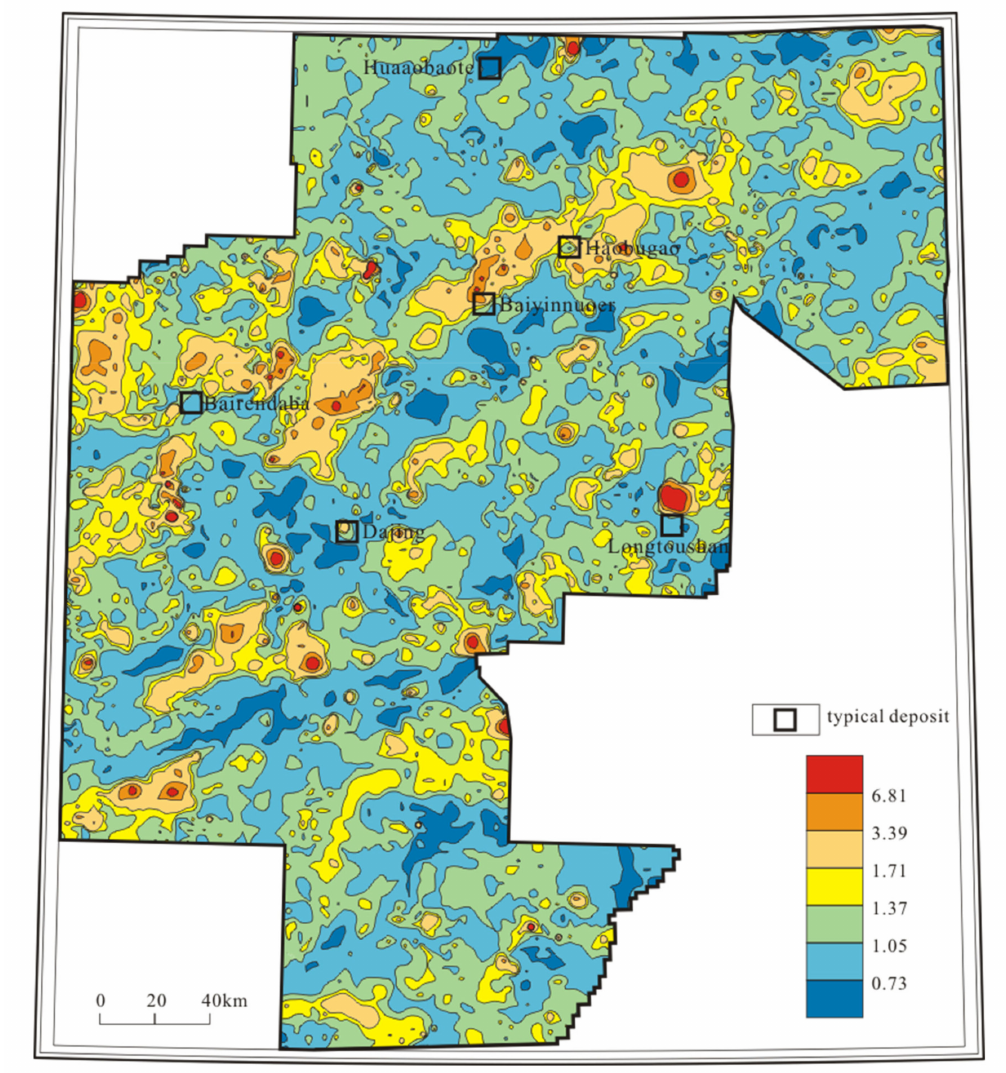
Figure 5. The contour map of the ratio of (W × Sn)/(As ×